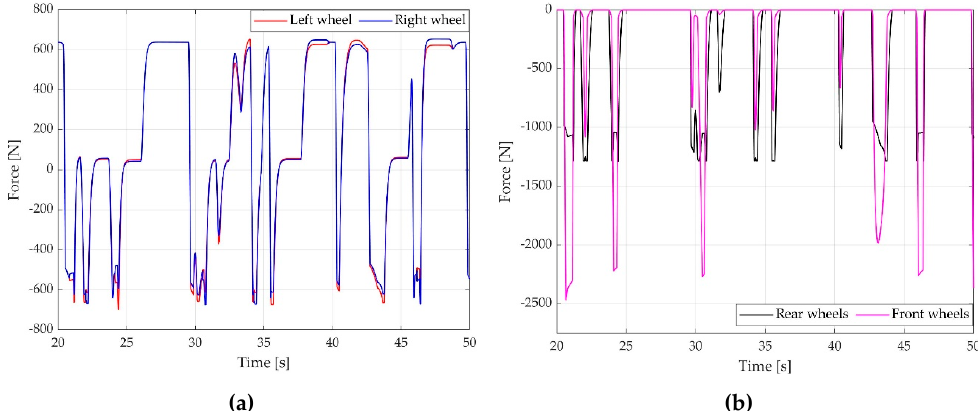
Figure 11. Braking forces distribution (a) Electric differential effect on left and right wheels; (b) Braking strategy effect in front and rear wheels.